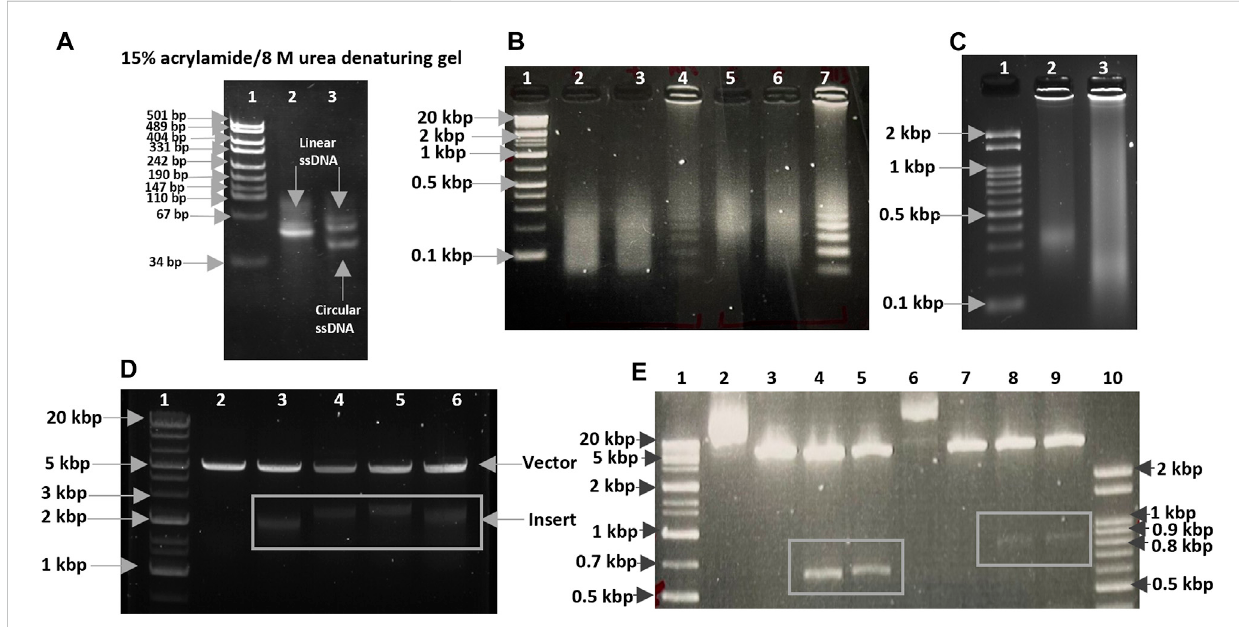
FIGURE 1 (A) CircLigase II ssDNA ligase converted 80 nt linear ssDNA oligos into circular ssDNA. Lane 1. pUC19 DNA/MspI (HpaII) Marker (Thermo Scienti fi c); Lane2.80 ntlinearssDNAoligos(upperband);Lane3.Unreacted80 ntlinear ssDNAoligos(upperband),and80 ntcircularssDNAproduct(lowerband). (B) RCA products after 1 h incubation. Lane 1. Size maker, Gene Ladder Wide 1 (0.1 – 20 kbp) (Nippon genetics co. 313-06961); Lane 2,3,5,6. RCA for SCA31; Lane4,7. RCAfor M13_90mer. (C) RCAproducts after 12 hincubation.Lane1.Sizemaker,GeneLadder100(0.1-2kbp) (Nippongeneticsco. 316-06951); Lane 2. RCA for SCA31 (12 h); Lane 3. RCA digested with 5 U mung bean nuclease and 0.5 U nuclease P1. (D) Size analysis of the TGGAA plasmids. Lane 1. Size maker, Gene Ladder Wide 1 (0.1 – 20 kbp) (Nippon genetics co. 313-06961); Lane 2. Restriction digestion of pIRES plasmid